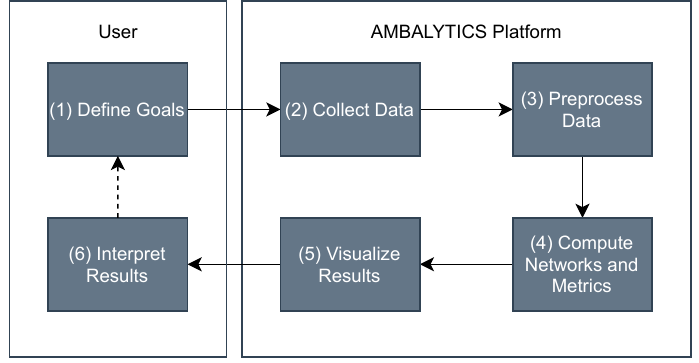
Figure 8. Bibliometric analysis